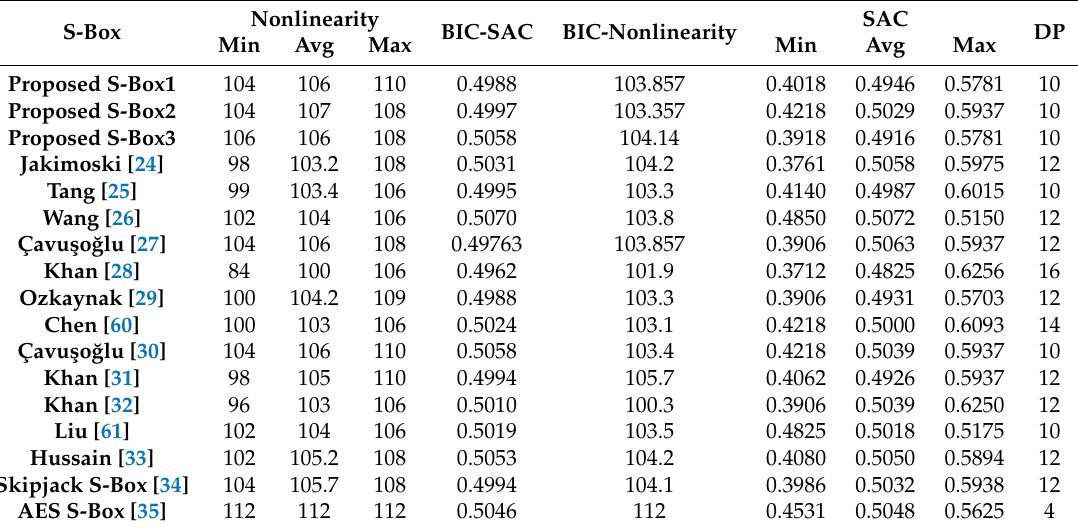
Table 4. The comparison of chaos-based